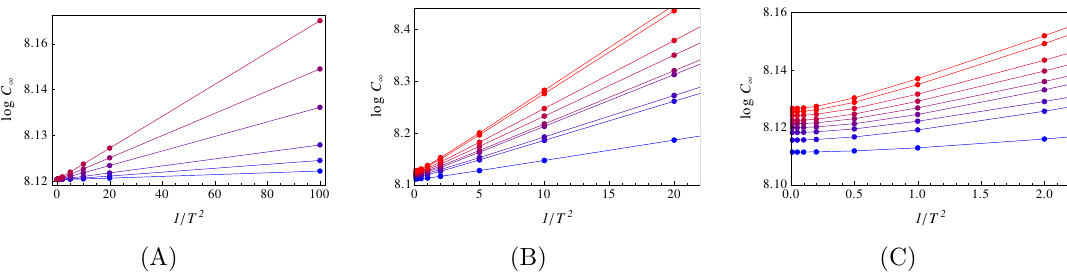
Figure 3. (A) The logarithm of the amplitude of the plateau C ∞ of the kinematic OTOC for the deviations σ = 0 . 05 , 0 . 1 , 0 . 2 , 0 . 4 , 0 . 6 , 0 . 8 (blue to red) as a function of temperature for β values. The linear dependence is nearly perfect, in accordance with the predicted scaling log C ∞ ∝ 1 /T 2 . The matrix size is N = 20 . (B) Same as (A) but for the deviation σ = 0 . 4 and varying matrix size N = 10 , 20 , 40 , 60 , 80 , 100 and 120 (blue to red). In (C) we bring the zoom-in of the plot (B) for high temperatures. Appart from a slight deviation near β = 0 , the behavior for larger matrices is still fully consistent with the analytical prediction. The solid lines are just to guide the